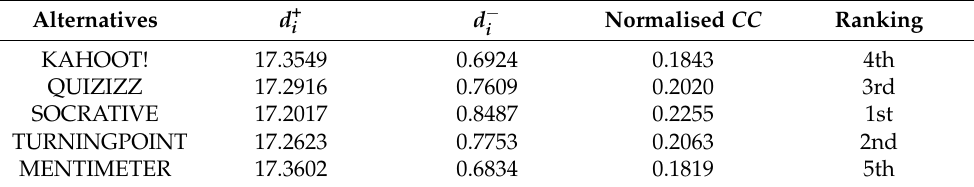
Table 10. The distances, normalised closeness coefficient, and ranking of alternatives in the case of W S = 0.5 and W O = 0.5, using objective weights from fuzzy De Luca and Termini entropy.